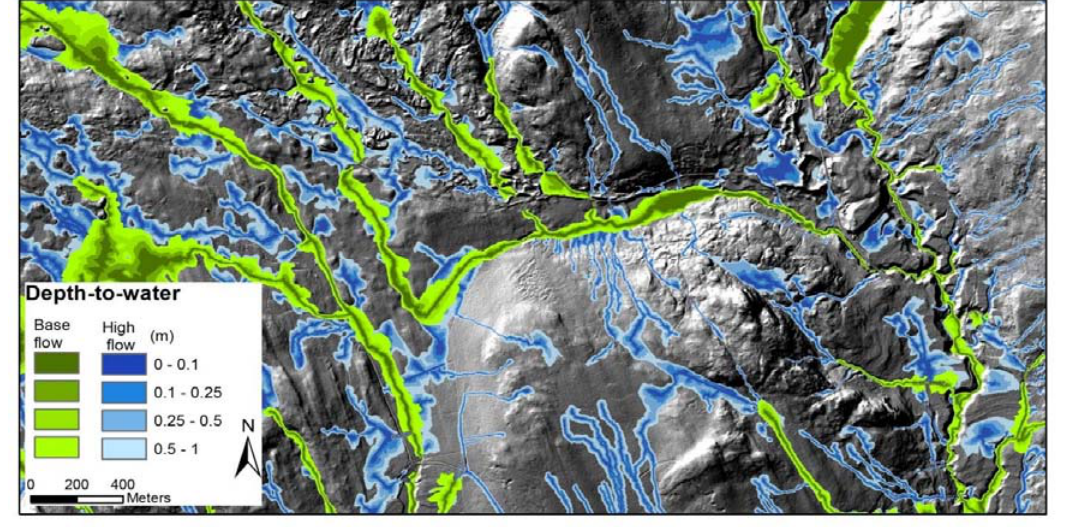
Figure 5. The black and white background map shows the sunlit elevation model of a subsection of the Krycklan catchment. Superimposed are the depth-to-water index maps which mark the wet areas along the stream network. Blue areas indicate wet areas during spring flood and green areas indicate areas that remain wet during baseflow. The darker colors (blue or green) indicate that the modelled groundwater level is closer to the soil surface and hence